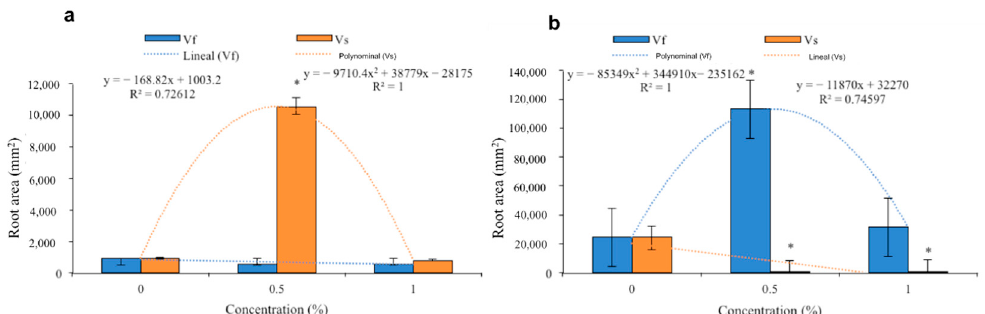
Figure 6. Effects of the aqueous extracts of Verbesina sphaerocephala and Verbesina fastigiata at different concentrations on root area in ( a ) Solanum lycopersicum and ( b ) Cucumis sativus . Columns denoted by an asterisk (*) are statistically different from the control. The values represent the average ( n = 20 seedlings); the bars represent the standard error.